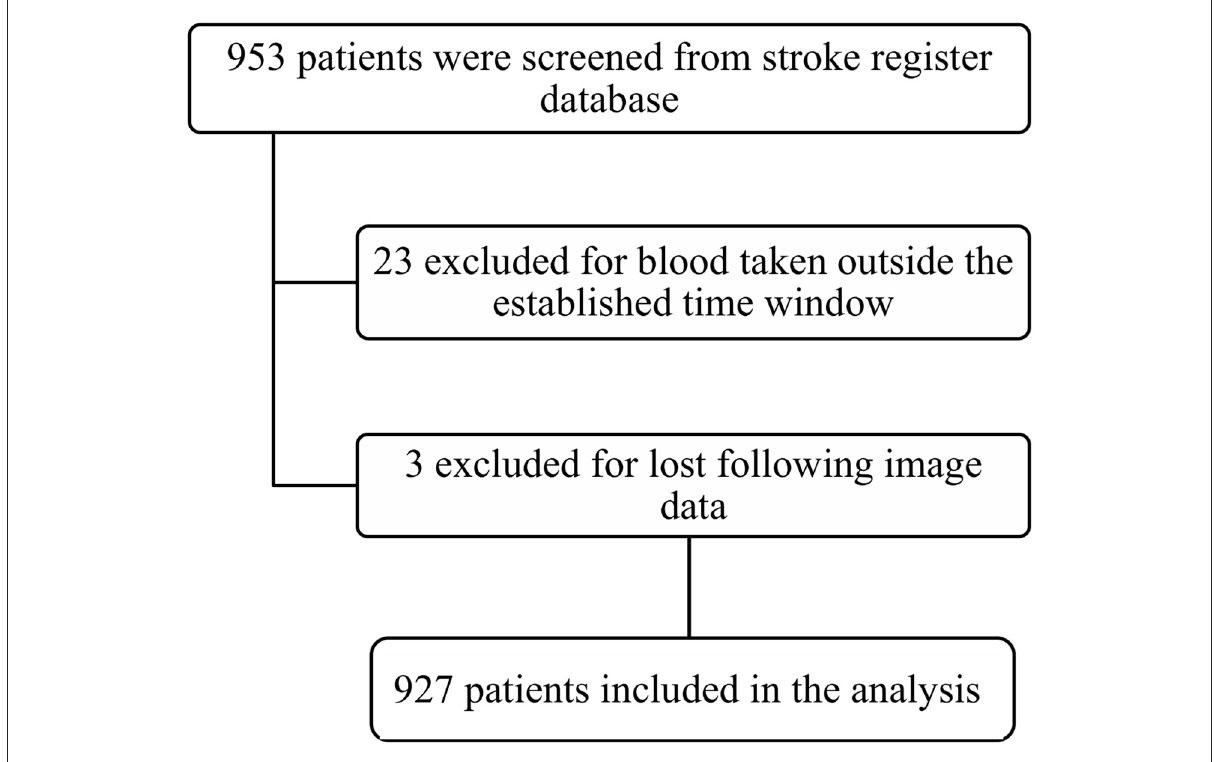
FIGURE1 Patient flow-chart of the